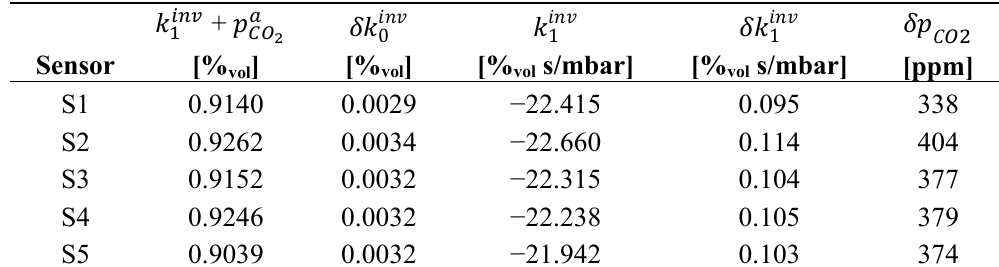
Table 5. Calibration constants from the inverse calibration method (correlation coefficient > 0.996) against the unknown background concentration (reference gas: air with added CO , outer matrix: air with added CO 2 2